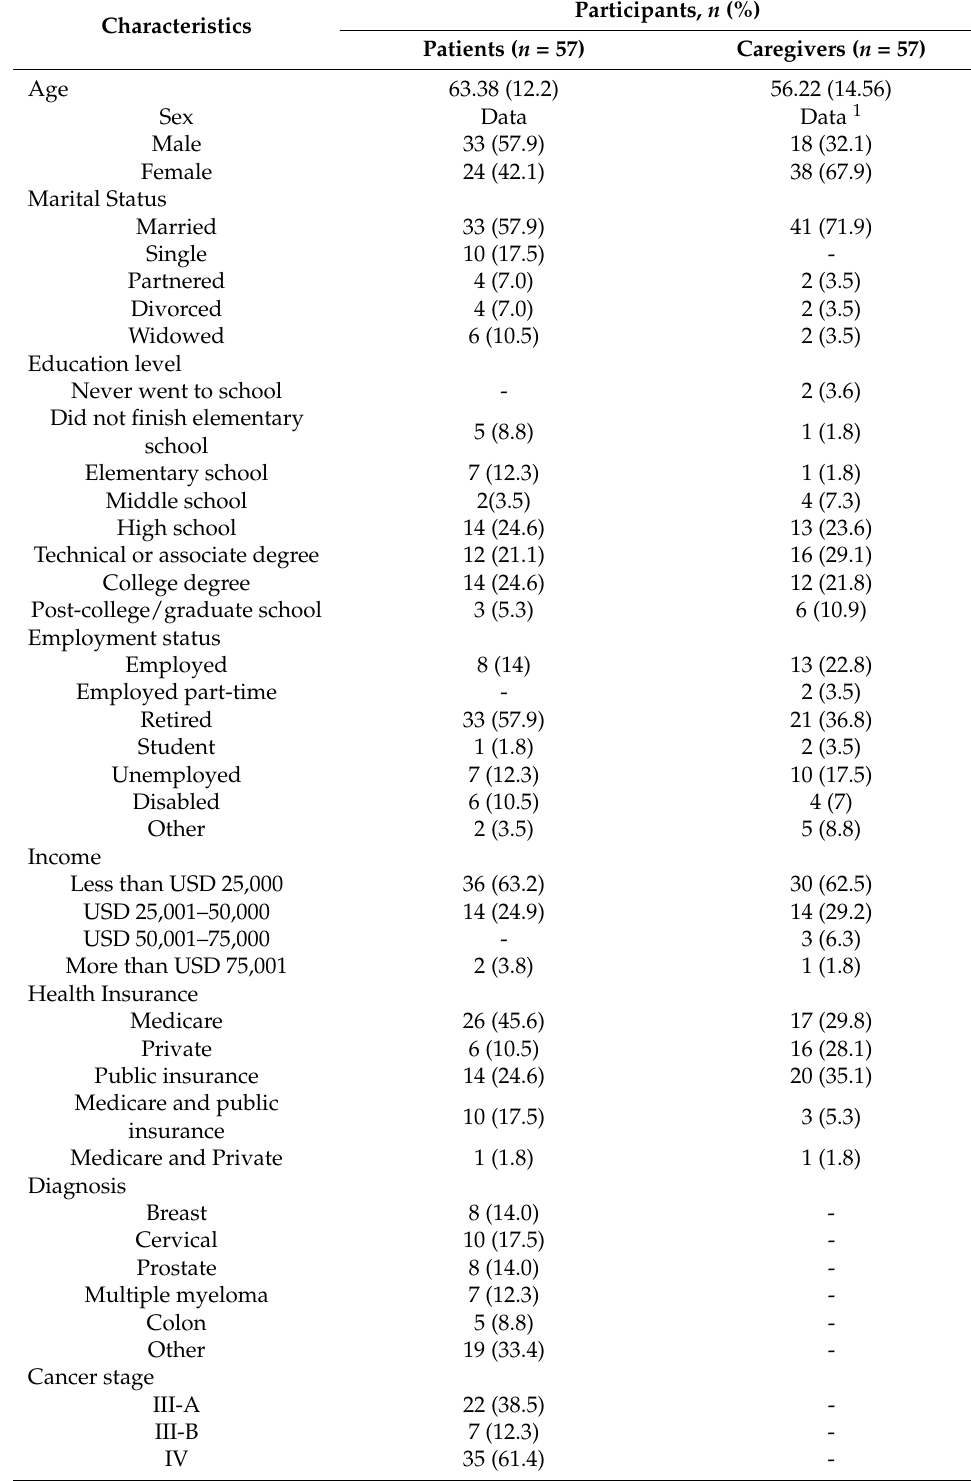
Table 1. Sociodemographic and clinical